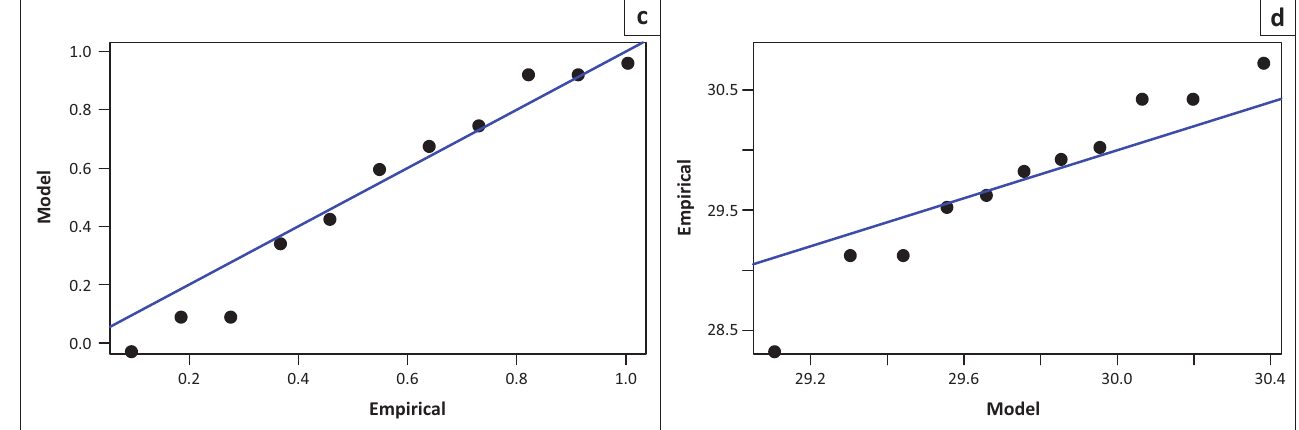
FIGURE 2-A1 (Continues...): Diagnostic plots illustrating the fit of the data (annual average maximum temperature) to the generalised extreme value distribution for r largest order statistics model with k = 5 and k = 6, (a) probability–probability plot for k = 5, (b) quantile–quantile plot for k = 5, (c) probability–probability plot for k = 6, and (d) quantile–quantile plot for k = 6.